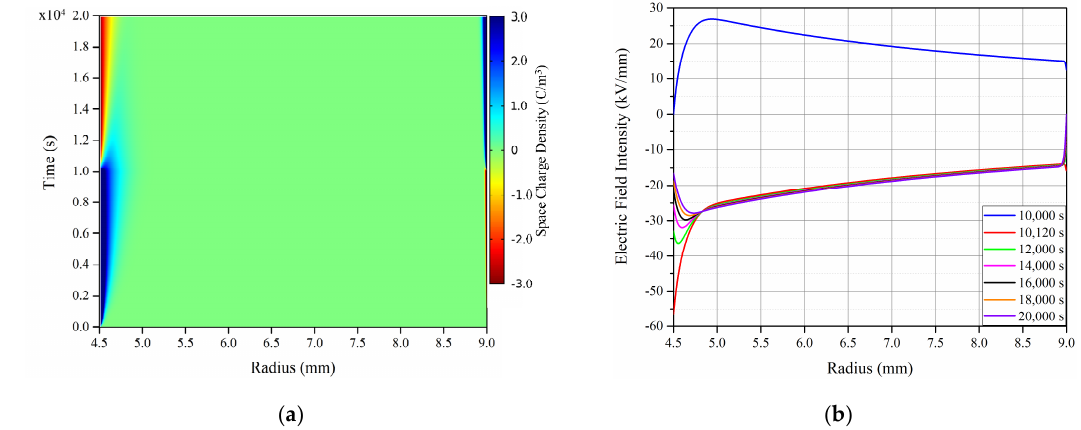
Figure 8. Time-varying electric field distribution at 250 A: ( a ) Within low-density polyethylene (LDPE); ( b ) at each point.